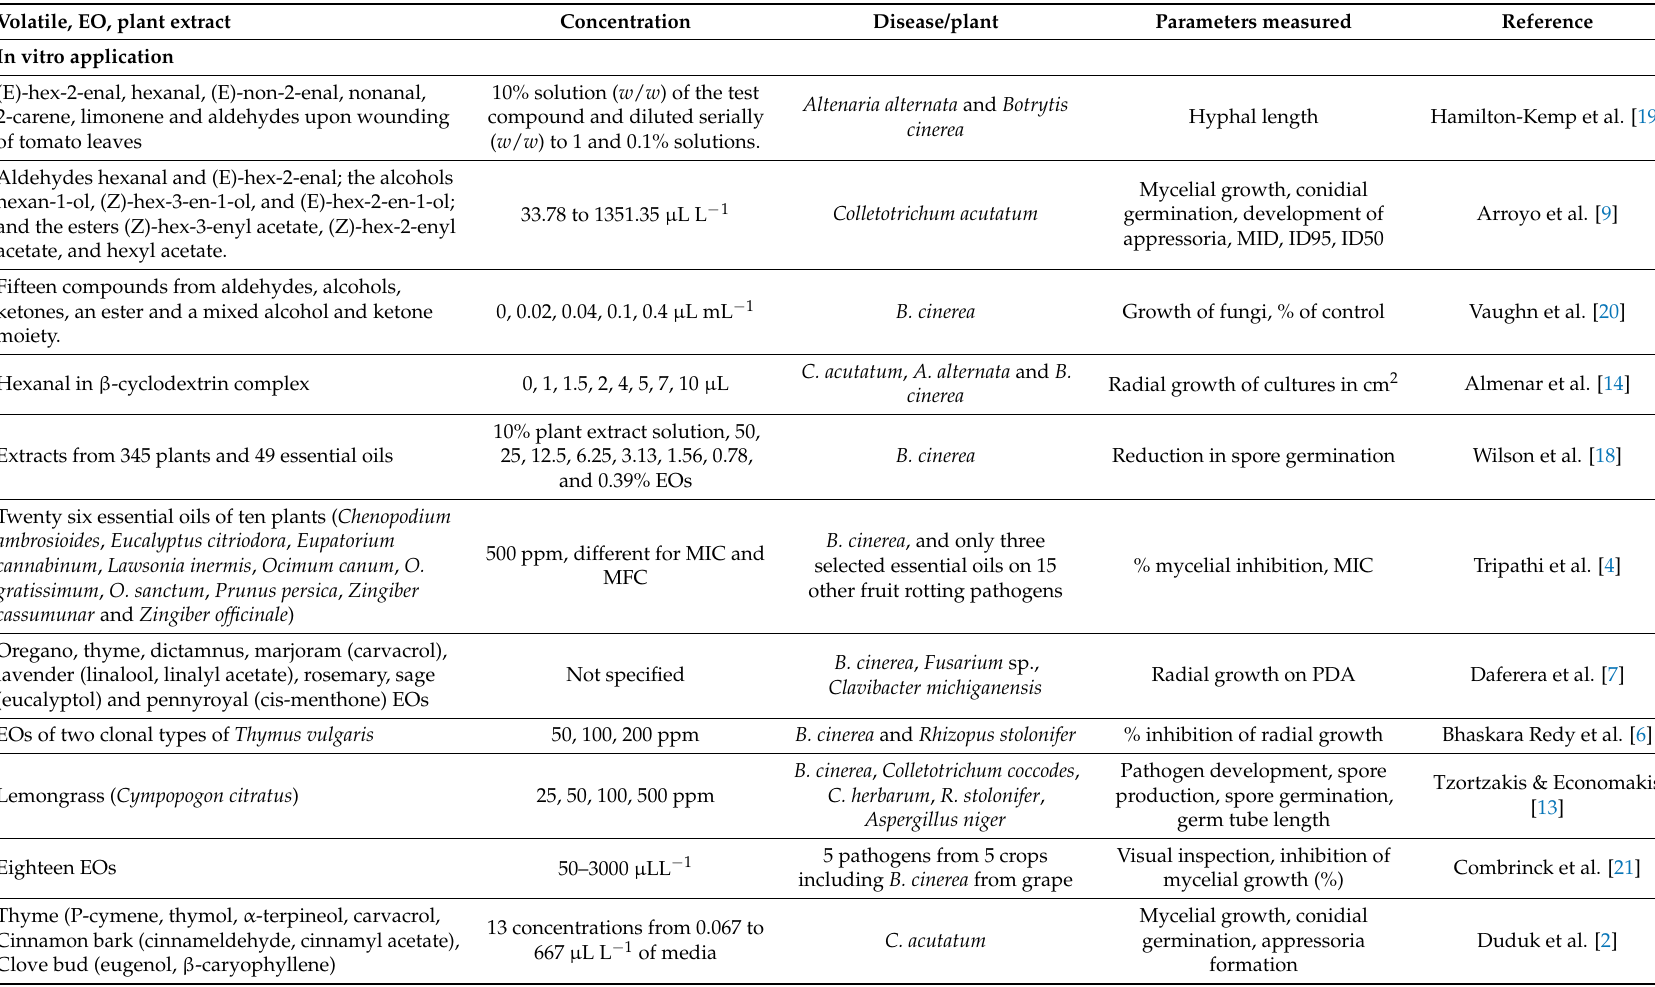
Table 1. In vitro, in vivo (in storage), and in situ (in field) applications of volatiles (single compounds) and essential oils (EOs, multiple compounds) on diseases and plants, and parameters measured. The abbreviations are explained in the